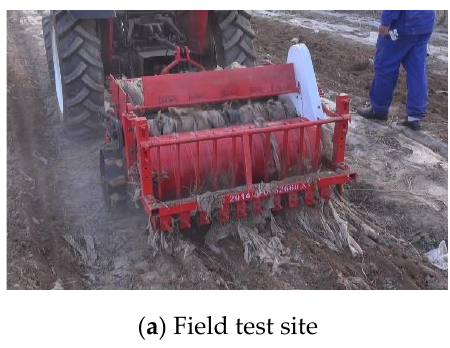
Figure 13. Field test of hug plate film-lifting parts.